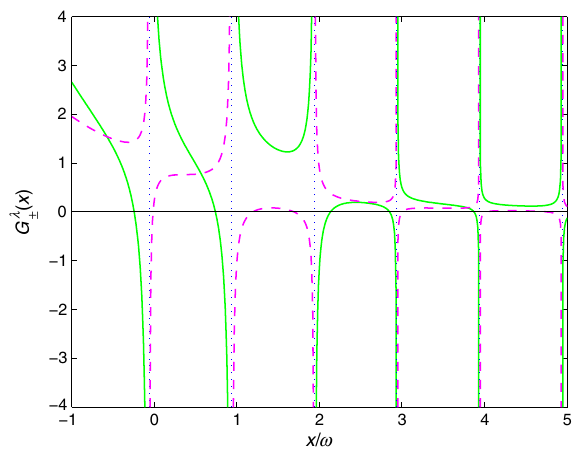
FIG. 2. Transcendental functions G λ ð x Þ (solid green line) and þ real part of G λ − ð x Þ (dashed purple line) for ϵ ¼ 0 . The parameters are ω ¼ 1 , g ¼ 0 . 7 , Δ ¼ 0 . 4 , λ ¼ 0 . 5 , and θ ¼ − π = 2 . The regular parts of the energy spectrum are determined by the 0 s of the transcendental function G λ ð x Þ , and the dotted vertical lines (cid:1) denote the poles x ≈ n − 0 . 0612 , n ¼ 0 ; 1 ; 2 ; … ; see Eq. (B13). Notice that the imaginary part of G λ − ð x Þ gives the same 0 and poles as the real part, which is not